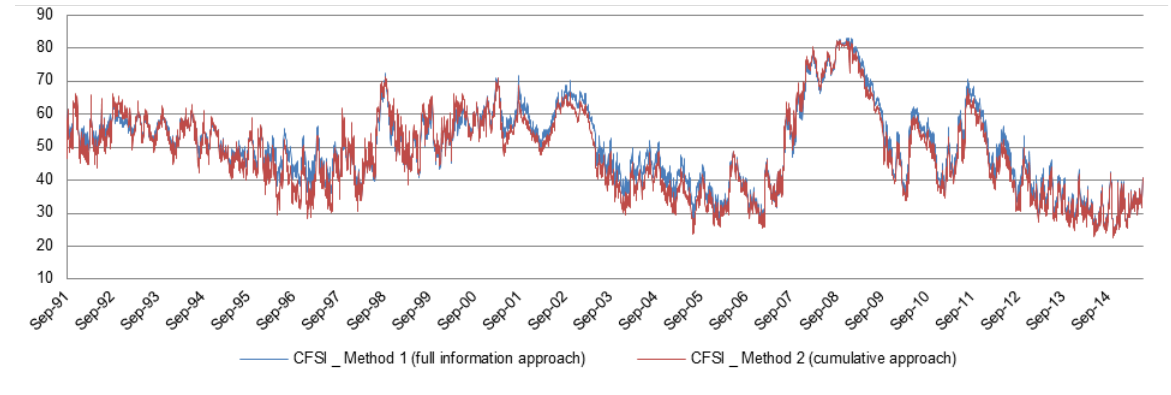
Figure 2. Comparison of CFSI using alternative approaches to CDF